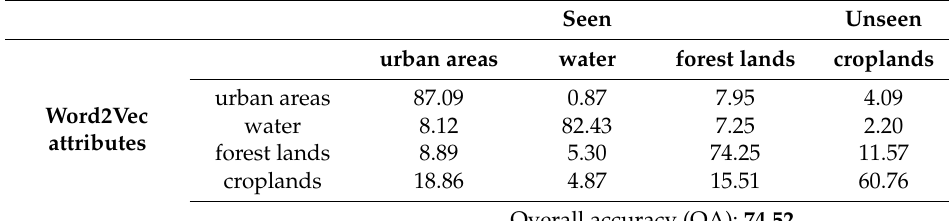
Table 4. The evaluation of GZSL classification results in the Flevoland data (%) (the unseen class is cropland).